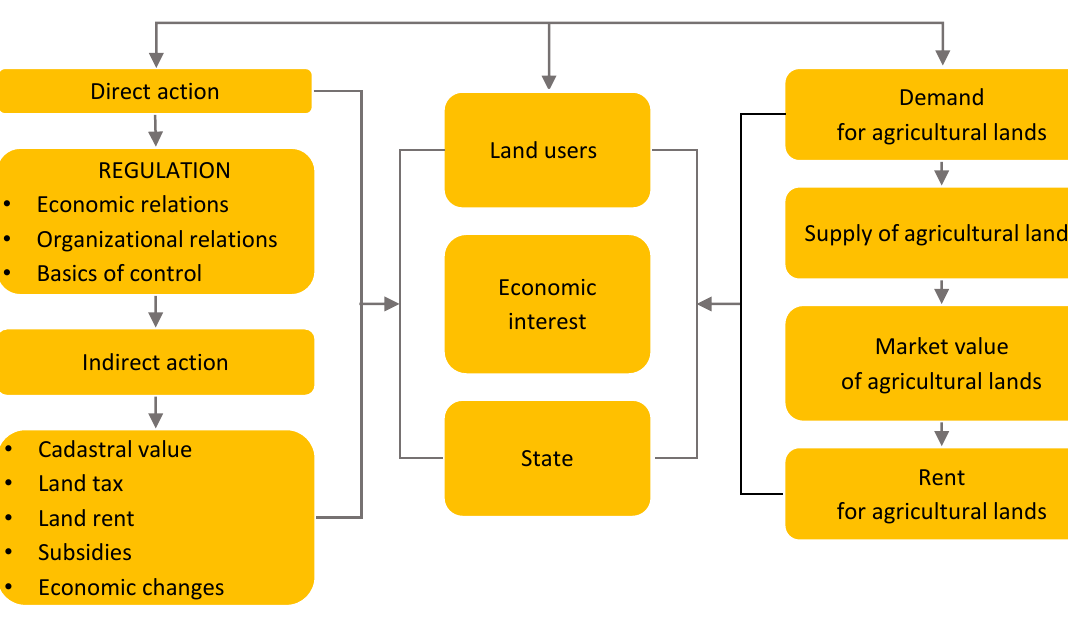
Figure 2. Elements of the mechanism of land issues management in